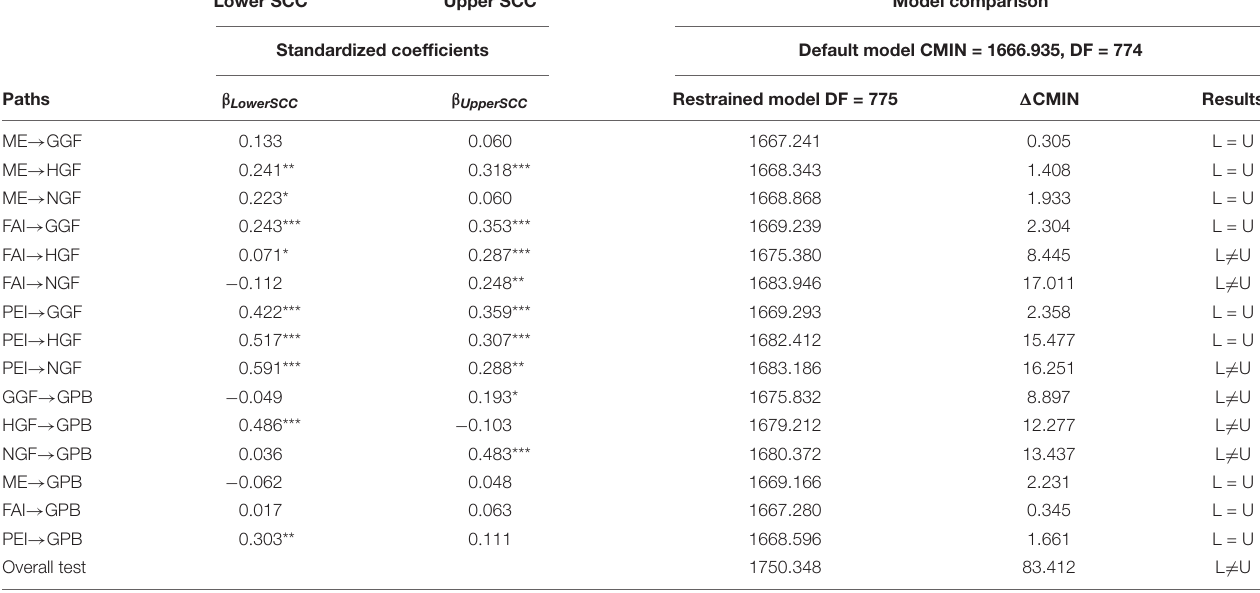
TABLE 4 | Moderated effects